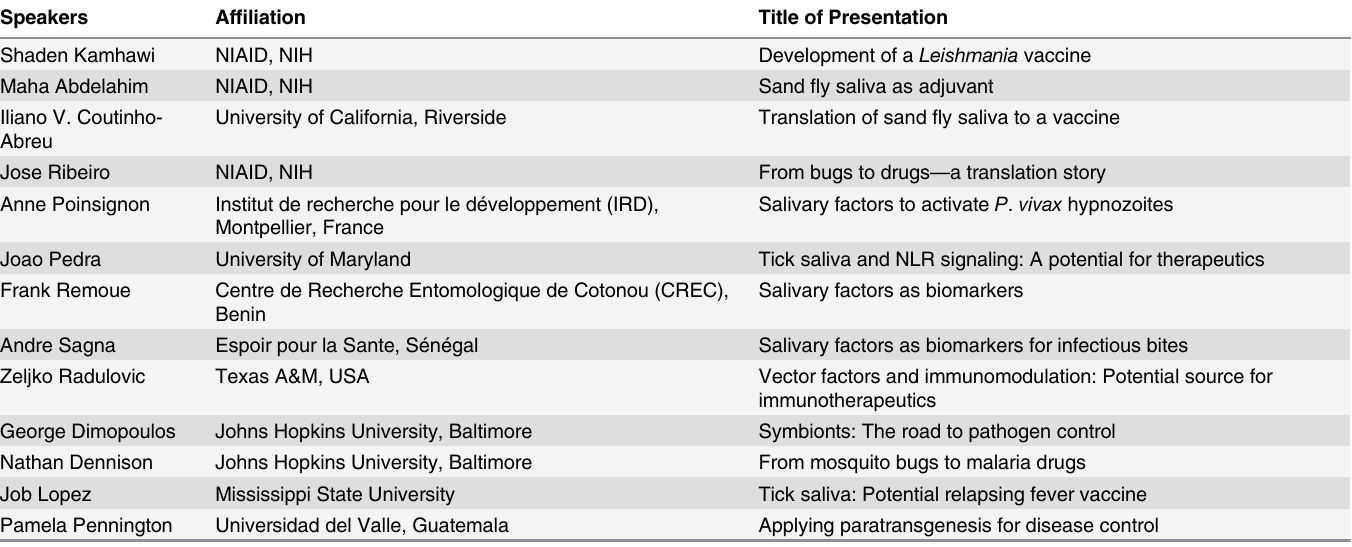
Table 1. Names and affiliations of speakers at the NIAID meeting “ Arthropod Vectors and Disease Transmission: Translational Aspects ” held May 2014. Speakers